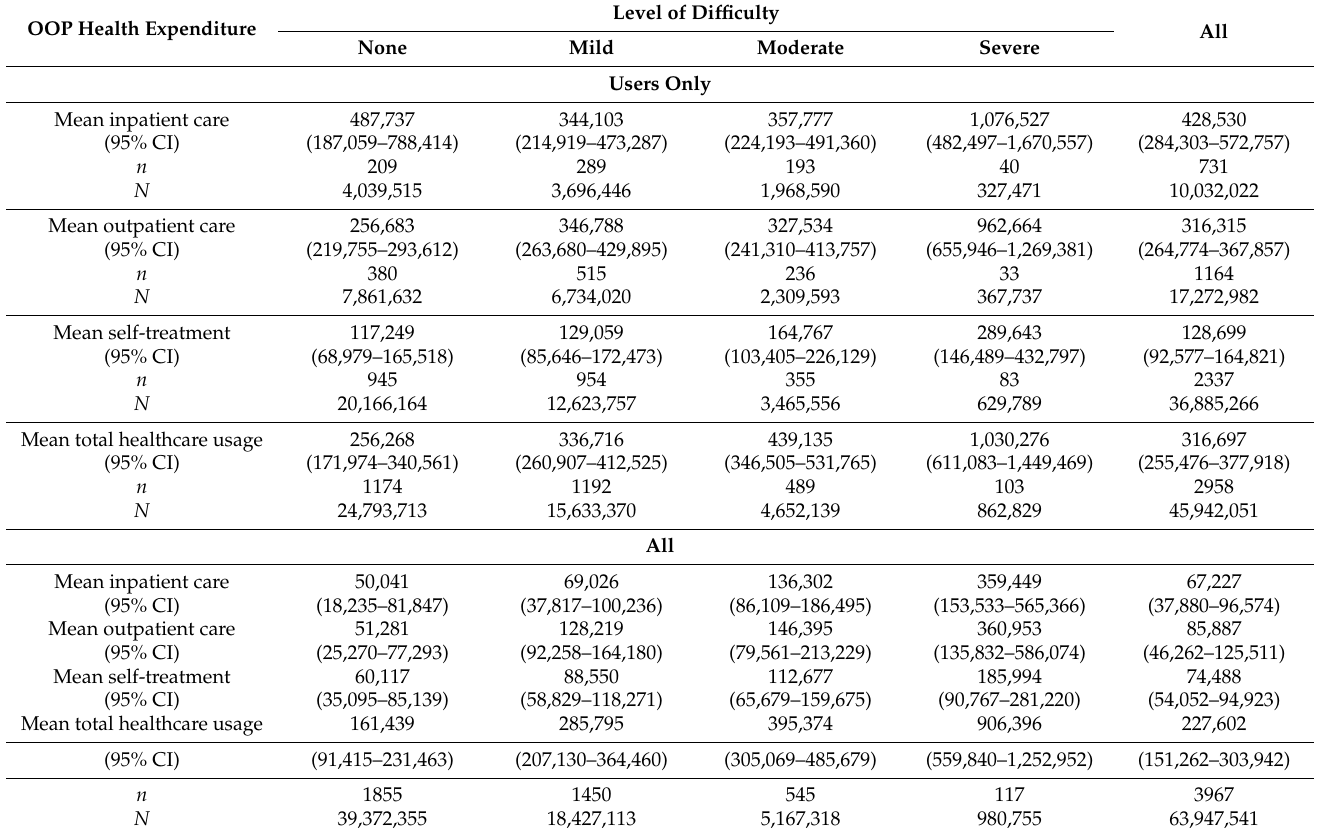
Table 3. Average monthly OOP healthcare expenditure (VND).